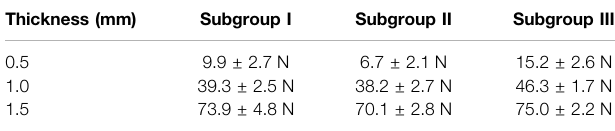
TABLE 1 | The lateral pull-out strength (N) in three sample thickness groups and subgroups: subgroup I: control, without implant site preparation; subgroup II, with mechanical drill; subgroup III: by femtosecond laser